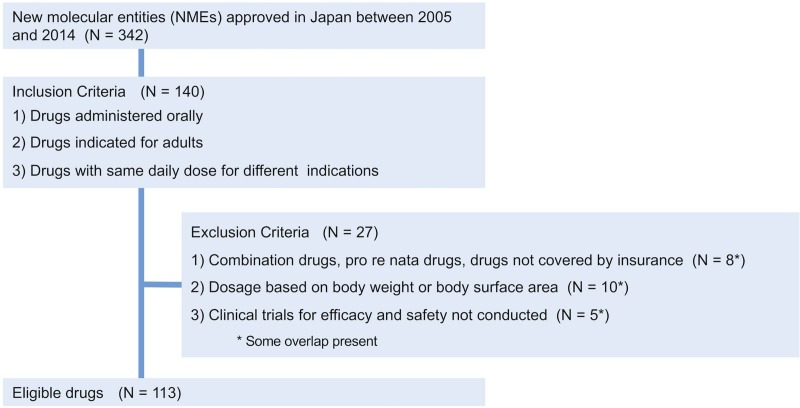
Flowchart representing the selection of drugs to be investigated.